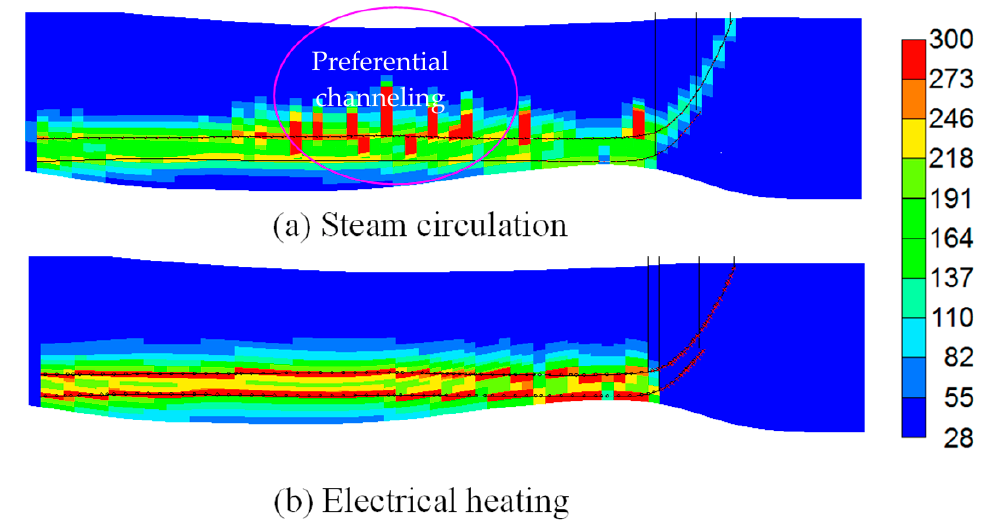
Figure 13. Temperature fields comparison of two preheating methods in pilot wellpair. From the SAGD production curves by different preheating methods (Figure 14), the oil rate at the early stage of SAGD production is similar for both cases. The main reason is that both steam chambers are small, with a low steam injection rate at the early stage, which results in almost the same ramp-up of the oil production rate [31,32]. However, the oil rate difference increases steadily with time, and, after converting to SAGD production for two years, both cases reach the SAGD plateau period and the peak oil rate for the case of electrical heating is 35 m 3 /day, while the case of conventional steam circulation is only 30 m 3 /day. The oil rate difference remains stable at a level of 3–5 m 3 /day during the entire plateau period. Meanwhile, at the late stage of production, it is evident that the case by electrical heating has a longer plateau period and much higher oil rate in the SAGD wind-down period, which indicates that the electrical heating improved the temperature conformance along the horizontal length, and more oil deposits become recoverable. The final oil recovery factor of the case with electrical heating start-up is 66.9%, which is 14.8% higher than the steam circulation case